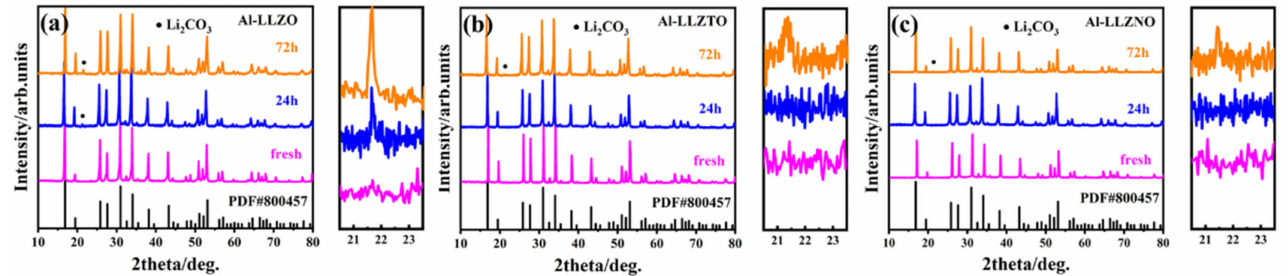
Figure 1. XRD patterns of ( a ) Al-LLZO, ( b ) Al-LLZTO, and ( c ) Al-LLZNO before and after 24 and 72 h of air